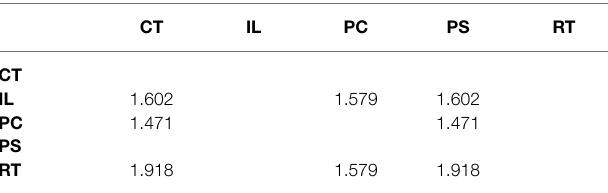
TABLE 5 | Collinearity statistics (inner VIF